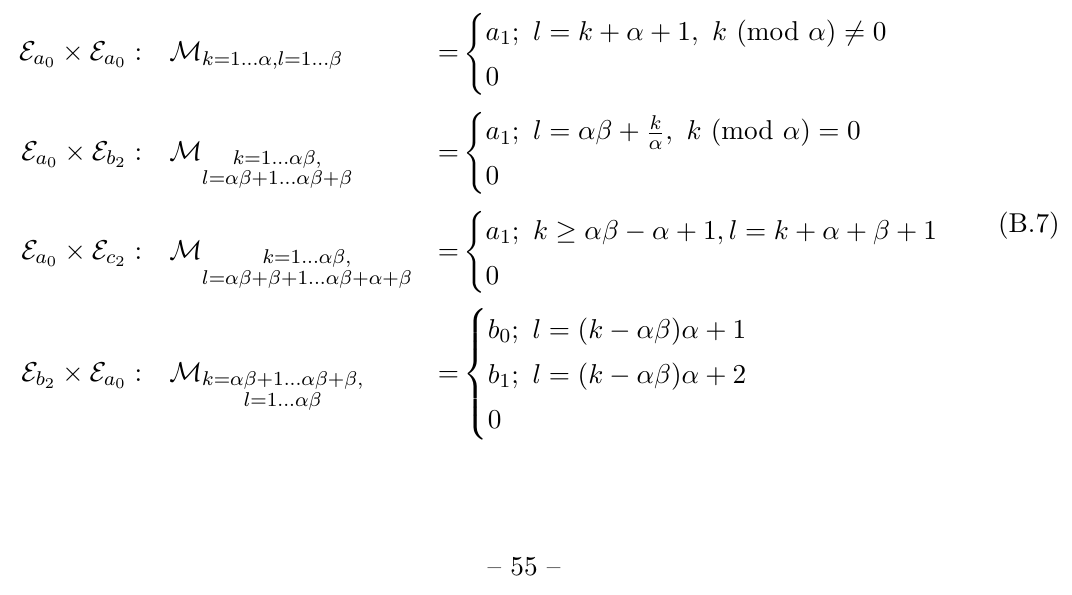
Figure 30 . The TCMD (B.5) divides Q into the three cells: a (cid:11)(cid:12) monomial a (cid:11)(cid:12)